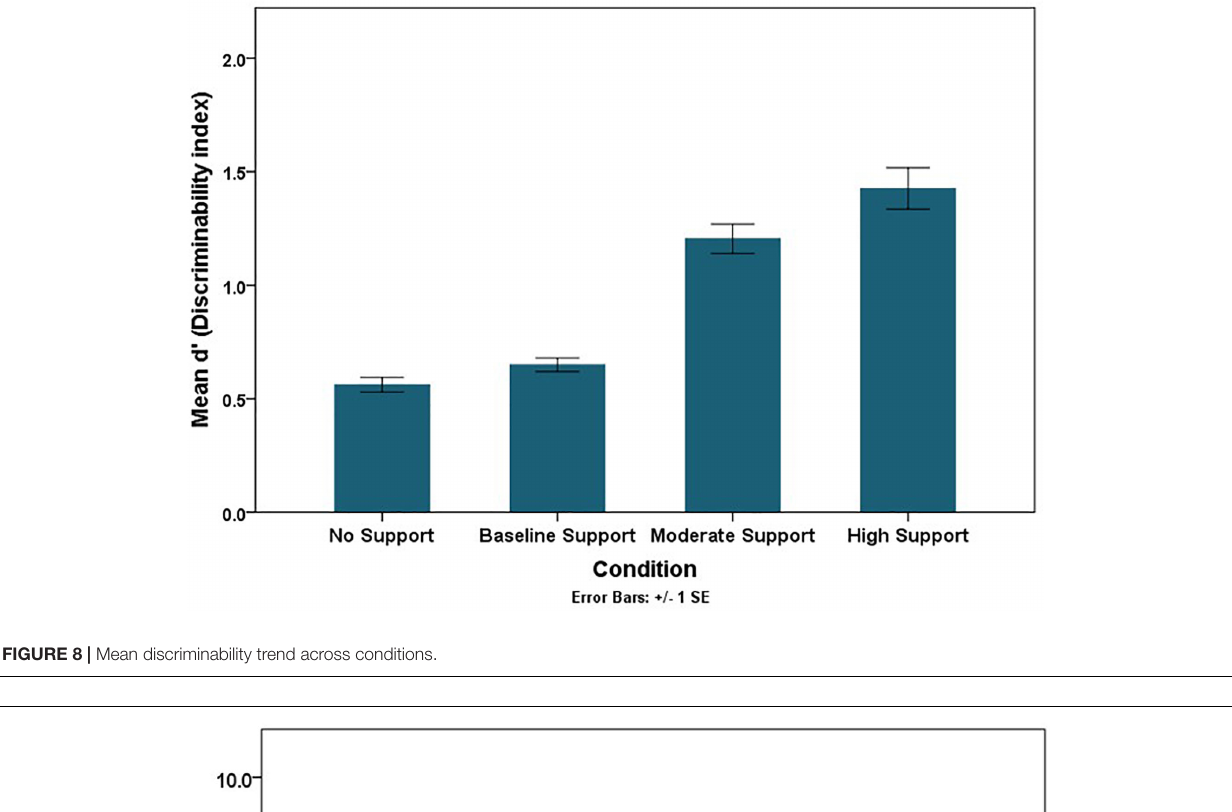
FIGURE 8 | Mean discriminability trend across conditions.